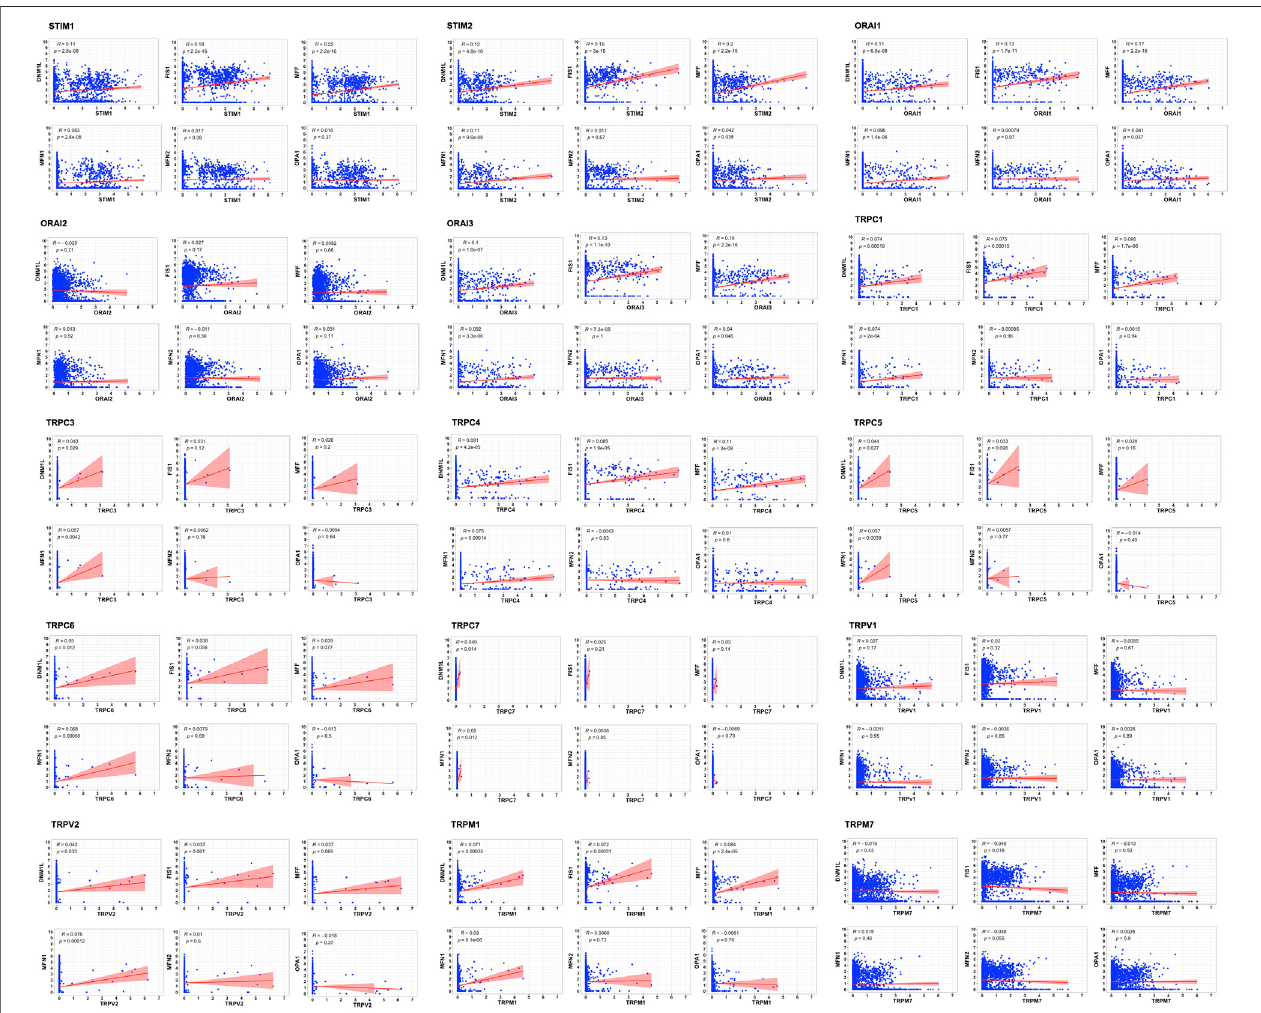
FIGURE 14 | Correlation of SOCs expression with MDGs in cancer cells across dataset GSE103322. The correlation between each SOCs expression (STIM1, STIM2,ORAI1,ORAI2,ORAI3,TRPC1,TRPC3,TRPC4,TRPC5,TRPC6,TRPC7,TRPV1,TRPV2,TRPM1,andTRPM7)versusMDGsexpression(DNM1L,FIS1,MFF, MFN1, MFN2, and OPA1) among the cancer cells are plotted using Corr plot package of R statistical environment. The linear regression lineper group is represented as red colored line. Inset- R value (correlation coef fi cient) and p value are